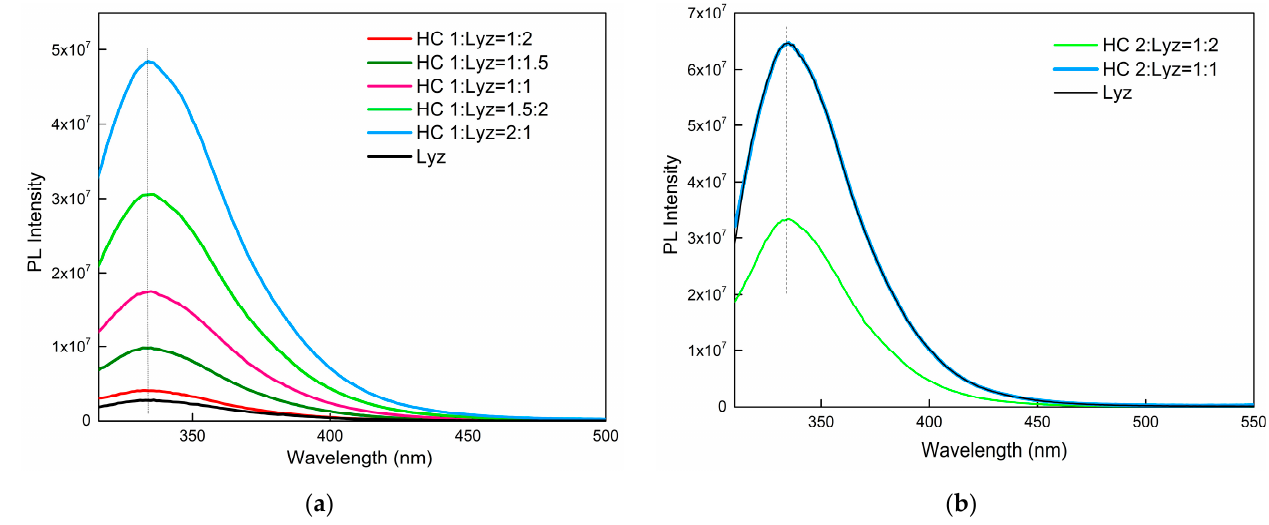
Figure 7. Fluorescence spectra of HC–Lyz complexes of ( a ) HC 1 and ( b ) HC 2.